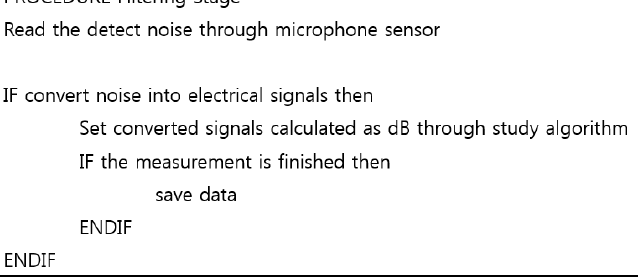
Figure 7. Filtering process stage.